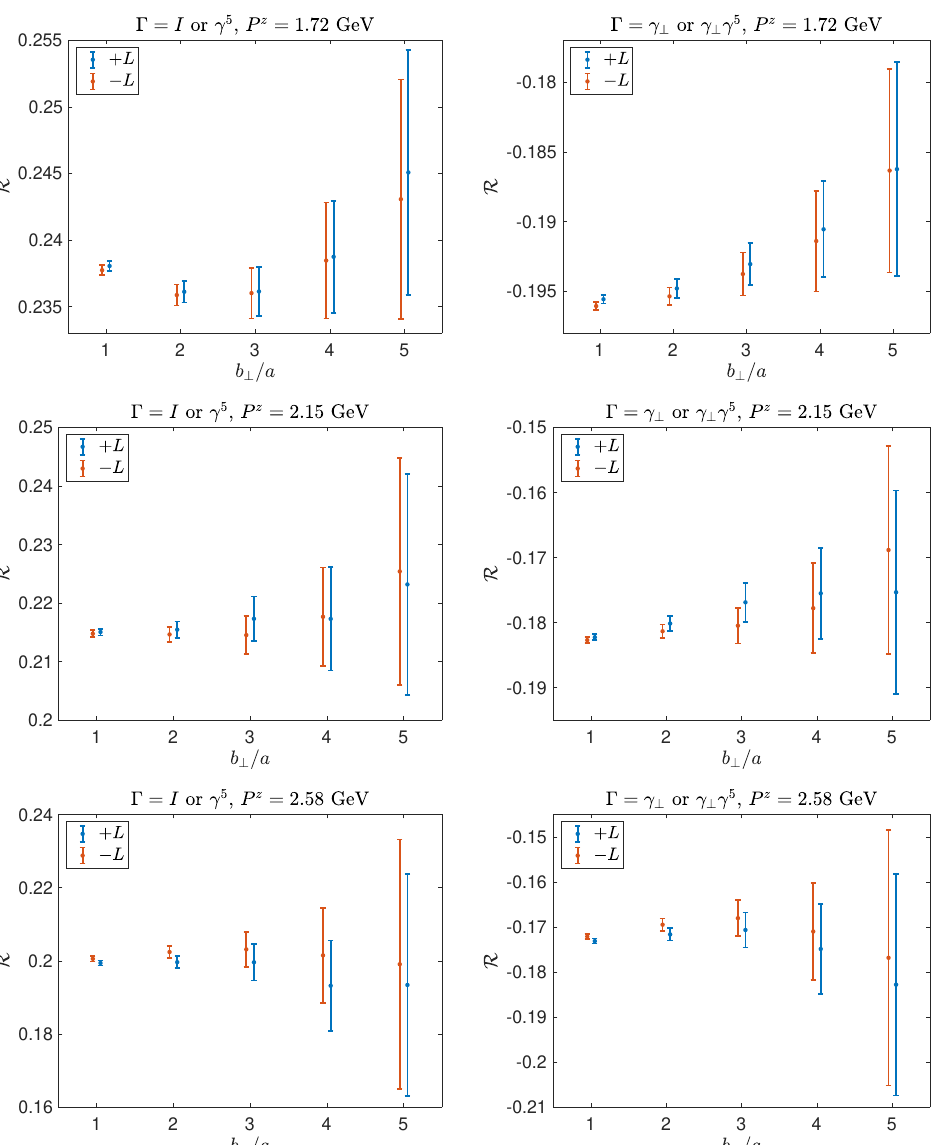
Figure 11 . One-loop QCD corrections to the denominator to extract reduced soft function as defined in eq. (5.3). The lattice data on quasi-TMDWFs from Lattice Parton Collaboration with P z = 1 . 72 GeV , 2 . 15 GeV and 2 . 58 GeV under b ⊥ = a, 2 a, 3 a, 4 a, 5 a ( a = 0 . 12 fm) is used [44]. The left panels show the results for Γ = Γ 0 = I, γ , while the right ones correspond to Γ = Γ 0 = γ 5 ⊥ , γ ⊥ γ 5